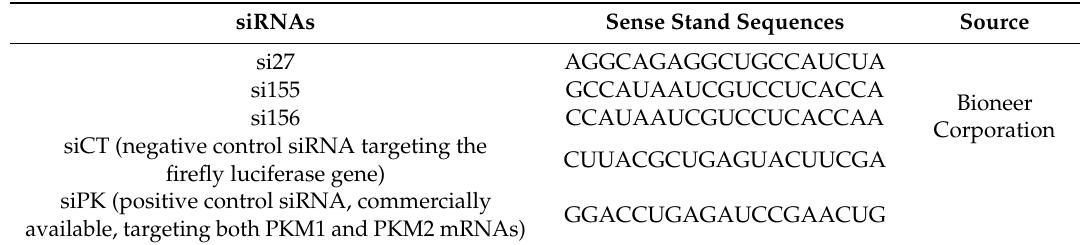
Table 2. Sequences of control and PKM2 siRNAs